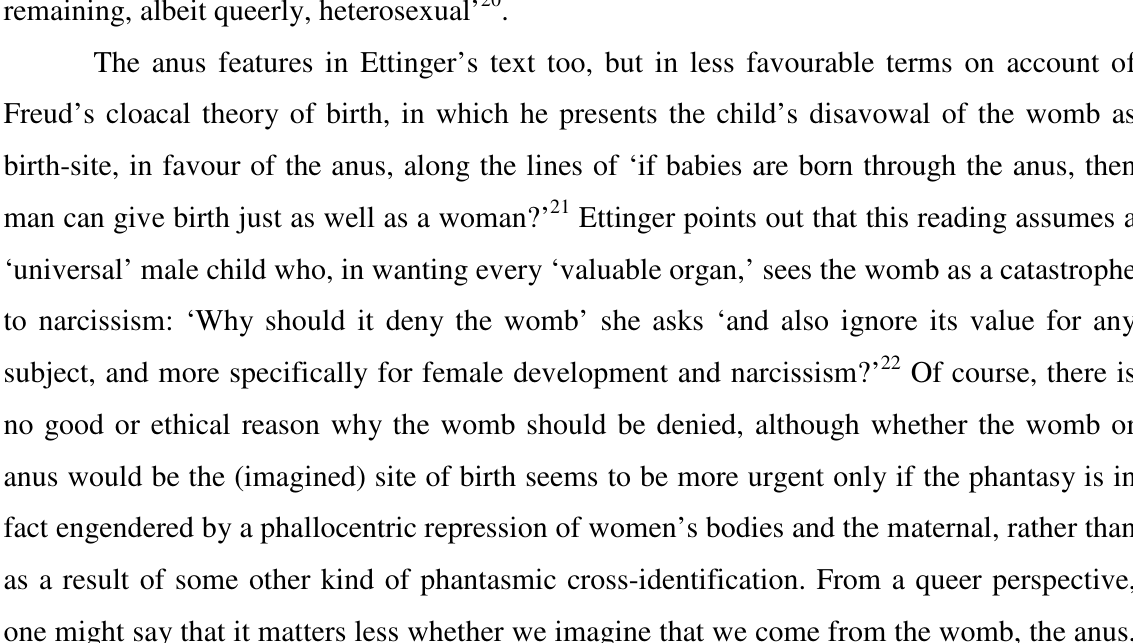
A view from Behind: Matrixiality, Masculinity, Queer Theory Studies in The Maternal, 1 (2) 2009,